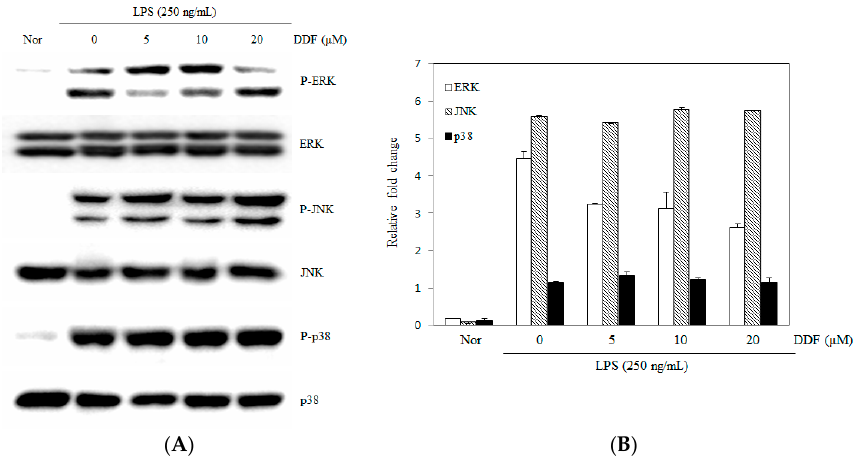
Figure 5. Effect of DDF on the phosphorylation of MAPKs in LPS-stimulated RAW 264.7 cells. Cells were treated with the indicated concentrations of DDF for 30 min prior to incubation with LPS (250 ng/mL) for a further 30 min. ( A ) Whole cell lysates were subsequently analyzed by immunoblotting; ( B ) Immunoblot signals were quantified using Molecular Analyst/PC densitometry software (Version 4.6, Bio-Rad). Densitometric analysis of phosphorylated isoforms is reported. The contents of ERK, JNK, and p38 in the cell lysate were normalized to the content of total form.